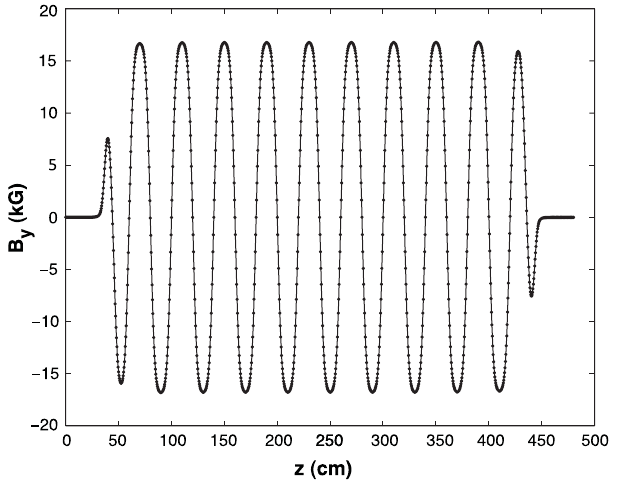
.FIG. 21. Fit to the proposed ILC wiggler vertical field versus z , where x ¼ 0 : 4 cm , y ¼ 0 : 2 cm . The solid line is computed using data on the surface of an elliptical cylinder with x max ¼ 4 : 4 cm , y max ¼ 2 : 4 cm , using the polynomial series for B obtained from (11) or (12). Dots represent numerical data provided by OPERA-3D